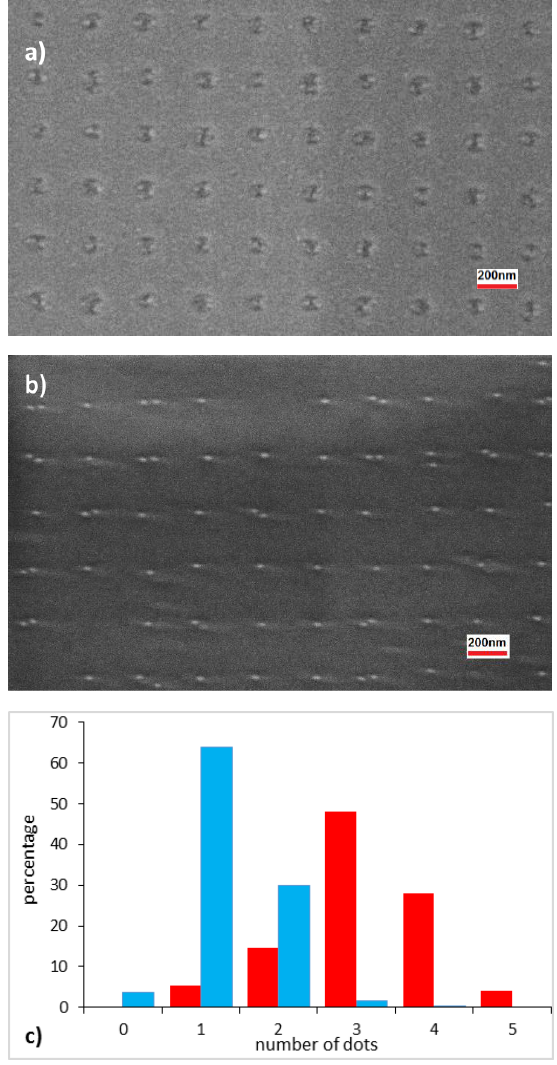
Figure 7. SEM images of ( a ) a single layer; and ( b ) a tenfold stack of site-controlled InAs/GaAs QDs grown on a nanopatterned GaAs hole array, deoxidized by In beams; ( c ) histogram showing the dot occupancy per hole on IAD patterns for a single layer (red) and a tenfold stack of InAs QDs (blue).